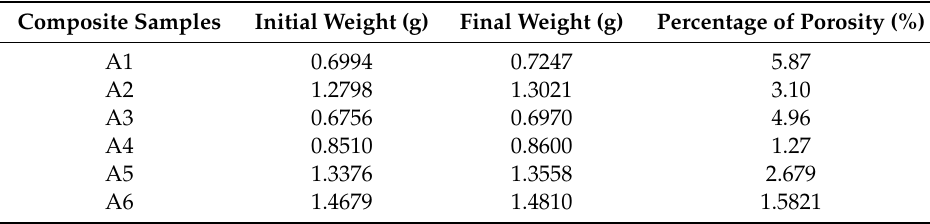
Table 5. Porosity percentage of GF / SF / CTS composite sca ff